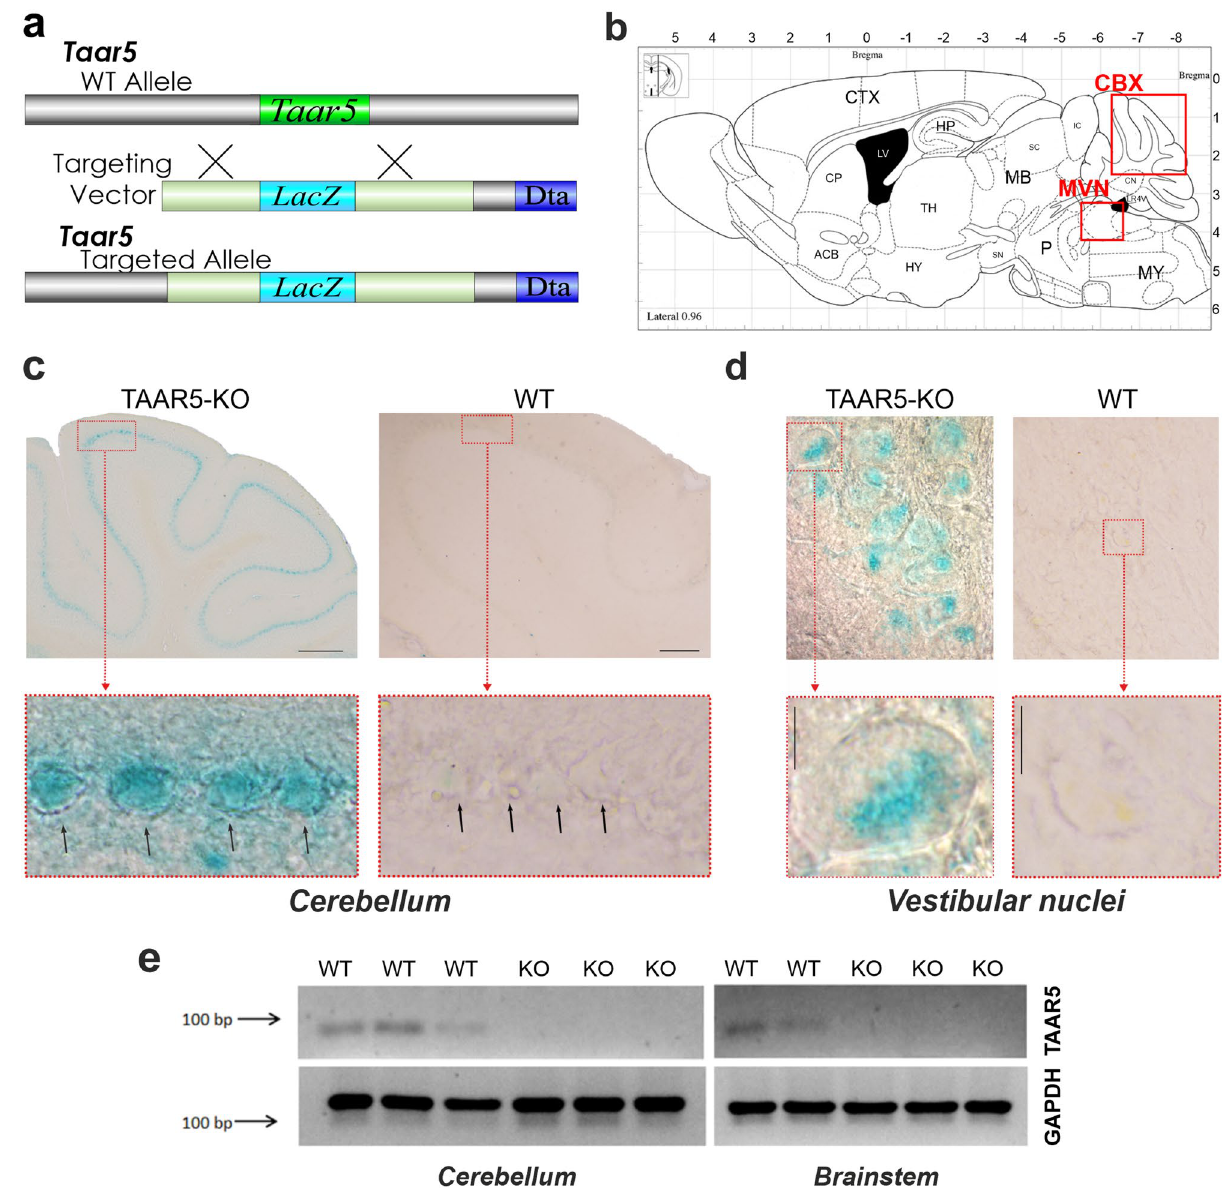
Figure 1. TAAR5 is expressed in the mouse cerebellum and medial vestibular nuclei. ( a ) TAAR5-KO mice were generated using homologous recombination that produces TAAR5 gene inactivation through a replacement vector. The target gene is aligned with the targeting vector containing LacZ-coding sequence 17 ; ( b ) a total sagittal view of the mouse brain (modified from Paxinos and Franklin the Mouse Brain in Stereotaxic Coordinates, 200121). ( c ) LacZ stained neuronal profiles of wild-type and TAAR5-KO mice in the Purkinje cell layer of the cerebellum (CBX). Dashed area is an enlarged view of the Purkinje cells. The calibration marker is 100 μm. ( d ) LacZ stained neuronal profiles of wild-type and TAAR5-KO mice in the medial vestibular nuclei (MVN). Dashed area is an enlarged view of the labeled cells. The calibration marker is 10 μm. ( e ) Reverse transcription- polymerase chain reaction (RT-PCR) analysis of TAAR5 mRNA expression in the cerebellum and brainstem of wild-type and TAAR5-KO mice. ACB nucleus accumbens, CBX cerebellum, CN cerebellum nuclei, CP caudate- putamen, CTX cortex, HP the hippocampus, HY hypothalamus, IC inferior colliculus, LR4V lateral recess of 4th ventricle, LV lateral ventricle, MB midbrain, MVN medial vestibular nuclei, MY medulla, P pons, SC superior colliculus, SN substantia nigra, TH